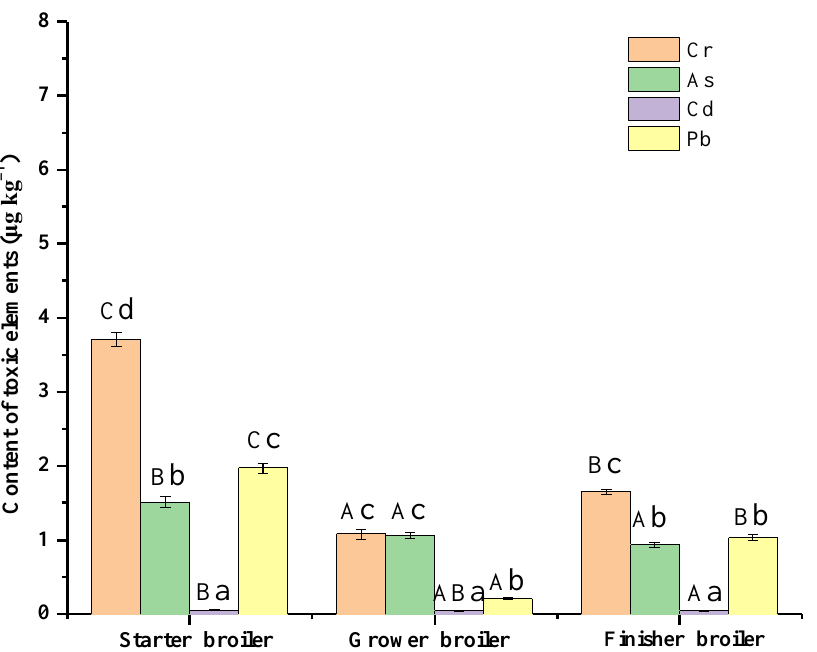
Figure 2. Toxic elements in chicken during the feeding stage. (Capital letters indicate significant differences in the content of the same element in a different feeding stage. Small letters indicate significant differences in the content of different elements in the same feeding stage).